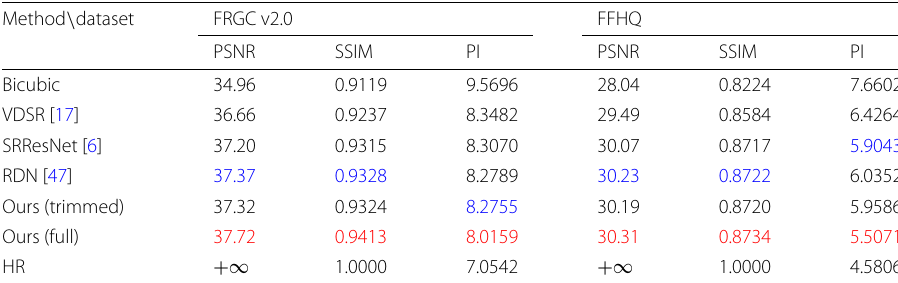
Comparisons on the test set for the scaling factor × 4. Red/blue color indicates the best/second best